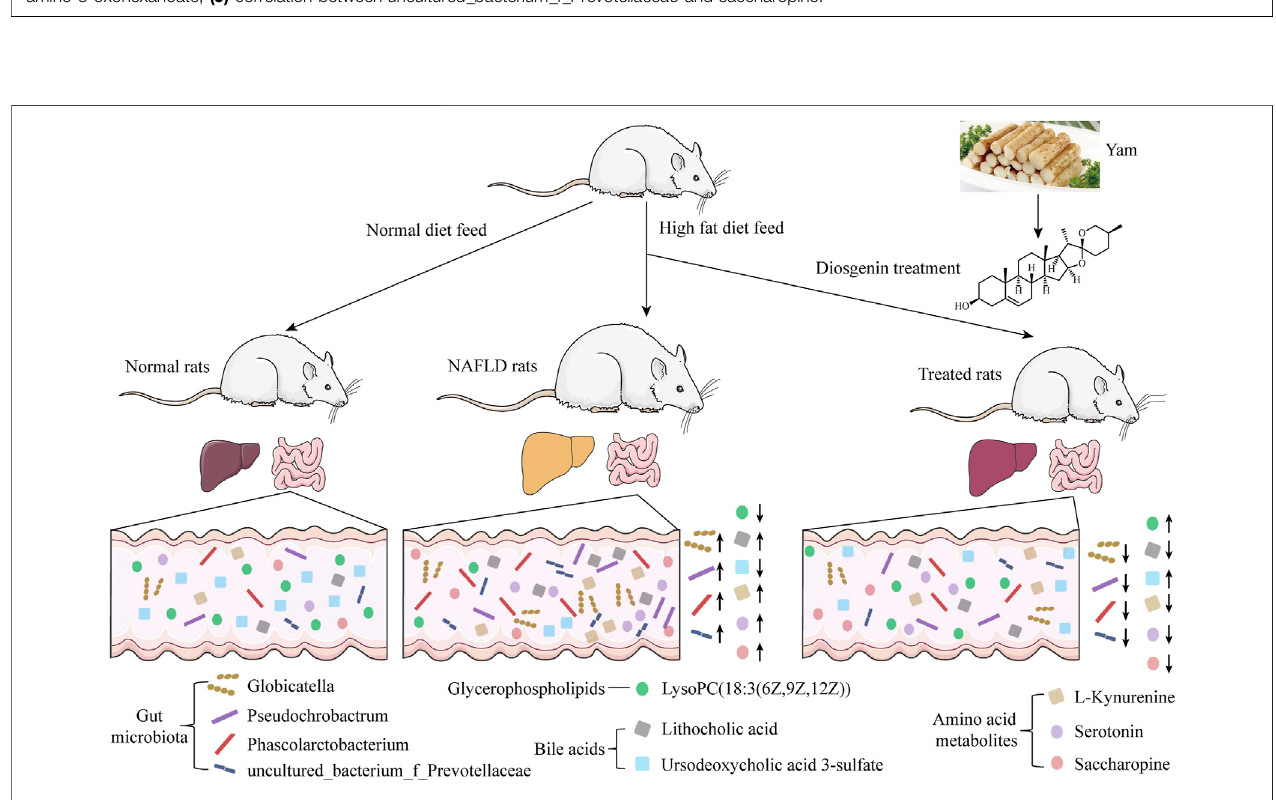
FIGURE 8 | The function of diosgenin in high fat diet induced NAFLD rats.